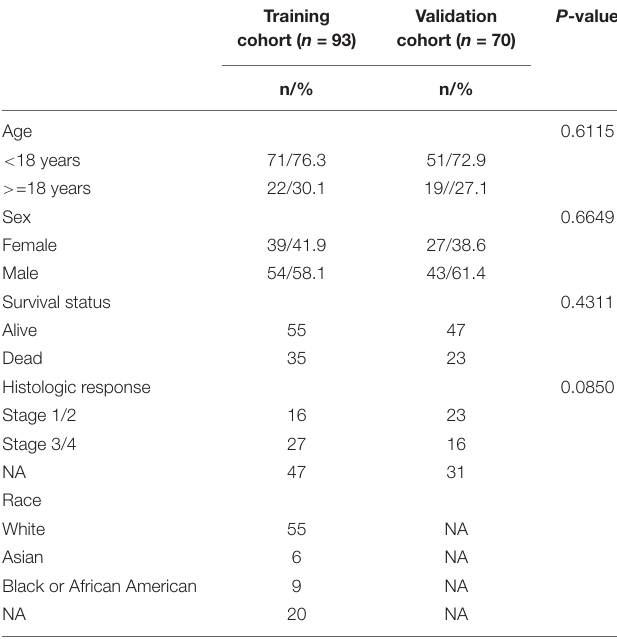
TABLE 1 | Characteristics of patients in the training and validation